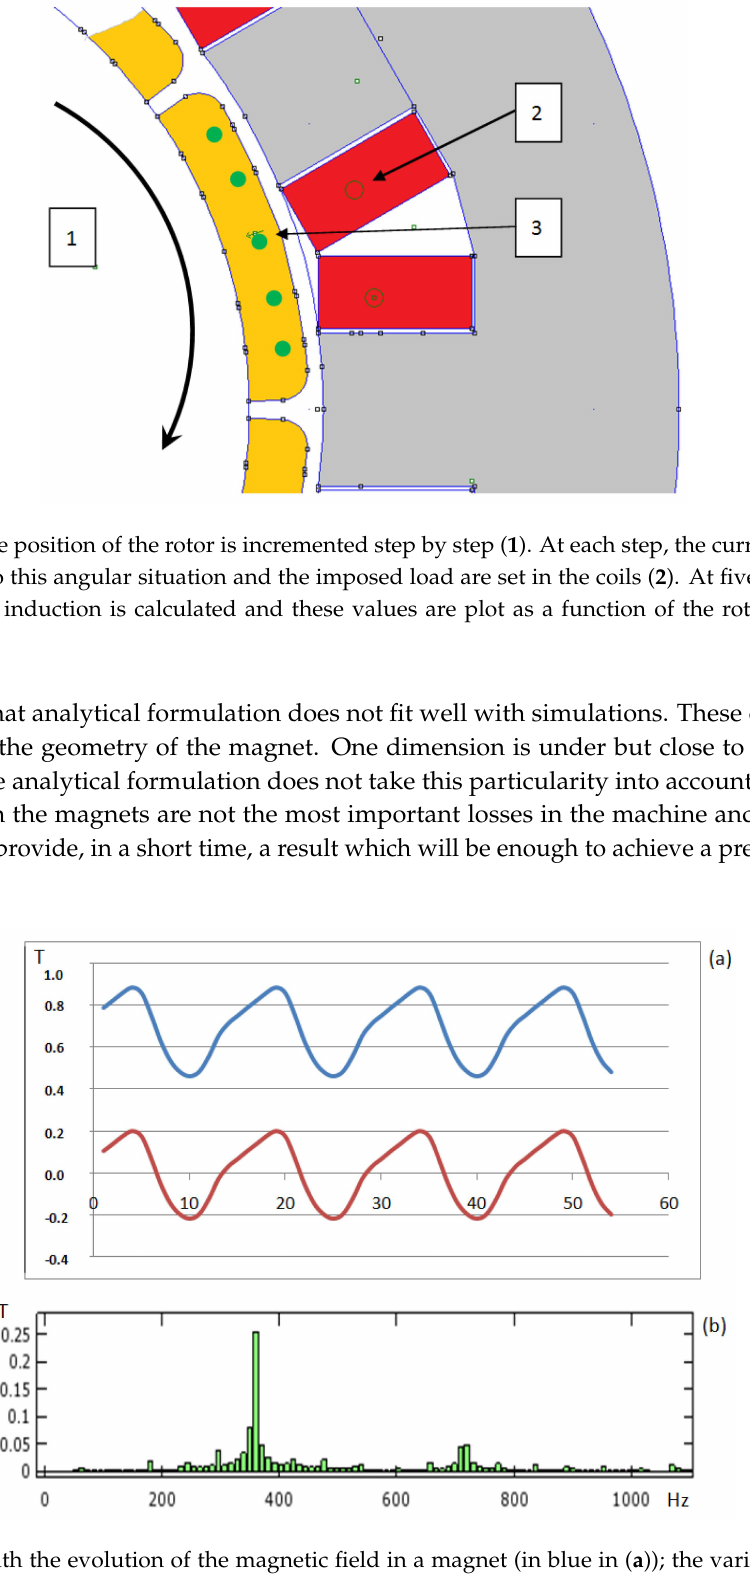
Figure 28. With the evolution of the magnetic field in a magnet (in blue in ( a )); the variable part is selected (in red in ( a )). Using the rotating speed of the rotor, the spectrum of the variable part of the magnetic induction in the magnet is calculated ( b ). With this spectrum, the eddy current losses in the magnet can be